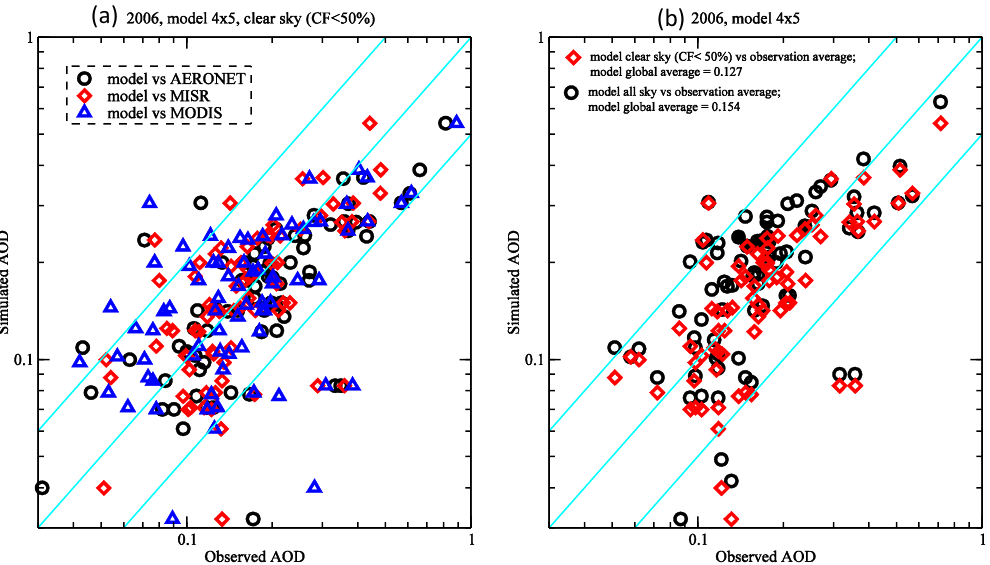
Fig. 7. Scatter plots of model predicted AOD versus observed AODs at the 77 AERONET sites, with panel (a) showing the modeled values under clear sky (CF < 0.5) versus AERONET, MODIS, and MISR data and panel (b) presenting modeled values under all sky and partially cloudy sky conditions versus AERONET, MODIS, and MISR averaged